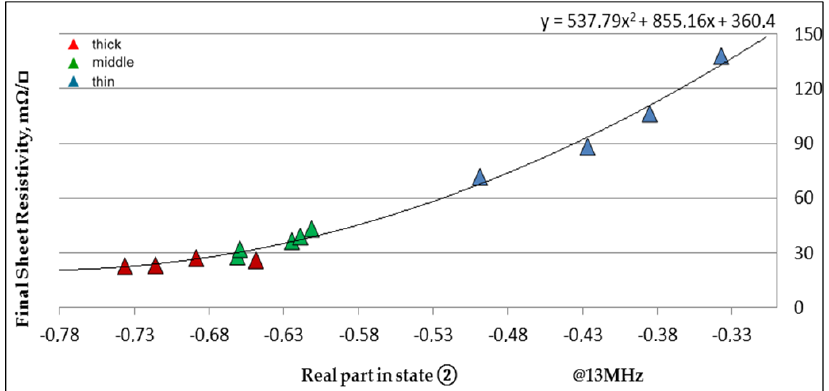
Figure 8. Correlations between the final sheet resistivity and the real part in state (1) at a frequency of 10 MHz for Cu/Ag films.